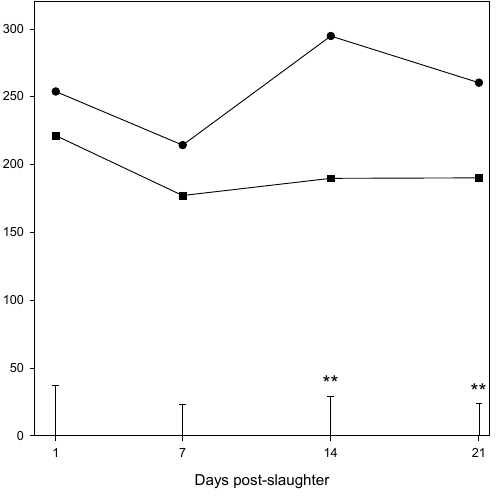
Fig. 2. Mean display life (hours of Minolta a* value ≥ 12) in M. longissimus from the fallow deer from two treatments (● pasture raised and ■ barley/hay-fed, n =12 in each group) included in the study, mea- sured after one day, and after opening the vacuum bag after 1, 2, and 3 weeks of refrigerated storage (+ 2 °C), with error bars indicating standard error of difference (S.E.D).